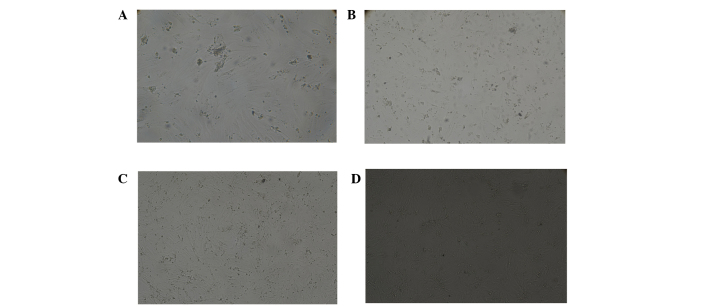
New Zealand rabbit BMSCs transfected with (A) Nkx2.5 (magnification, ×400) or (B) GATA-4 (magnification, ×200) and cultured for two weeks. New Zealand rabbit BMSCs transfected with (C) Nkx2.5 (magnification, ×200) or (D) GATA-4 (magnification, ×200) and co-cultured with heart cells for two. BMSCs, bone marrow mesenchymal stem cells. Images show the results of four samples taken from the same area.